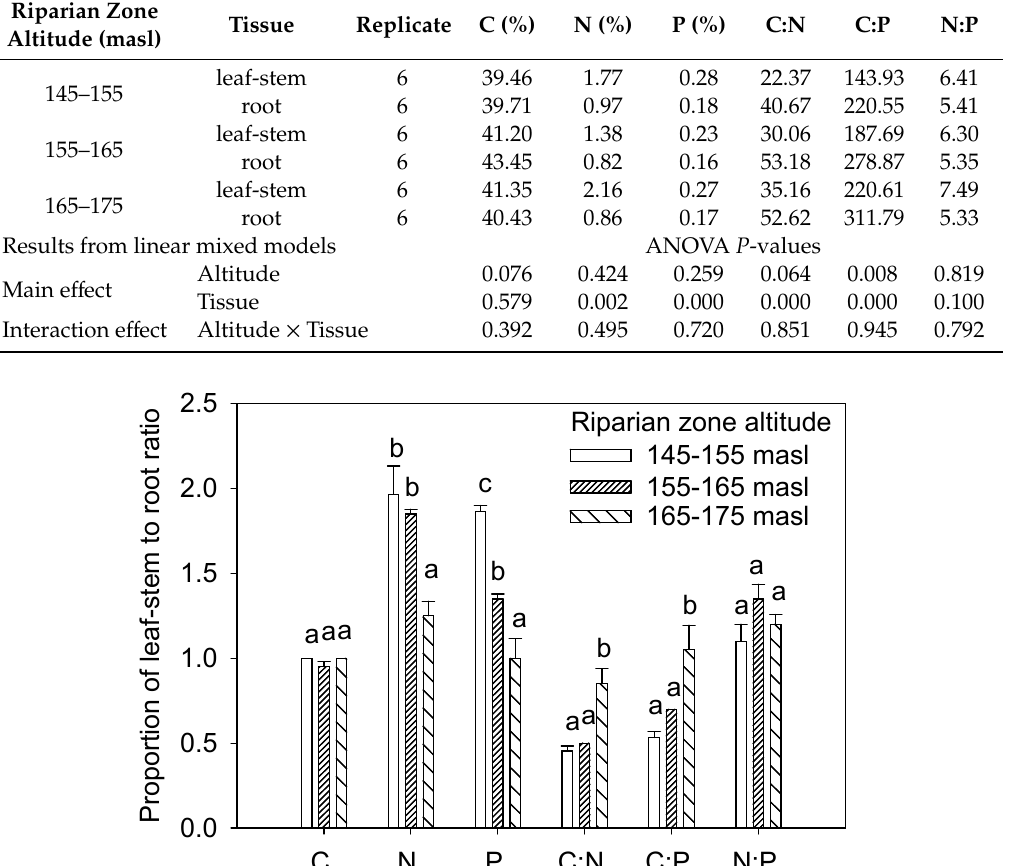
Figure 4. C:N:P stoichiometry in the leaf-stem to root ratio among the riparian zone altitudes. Different lowercase letters of a, b, c indicate significant differences among riparian zone altitudes at p < 0.05.